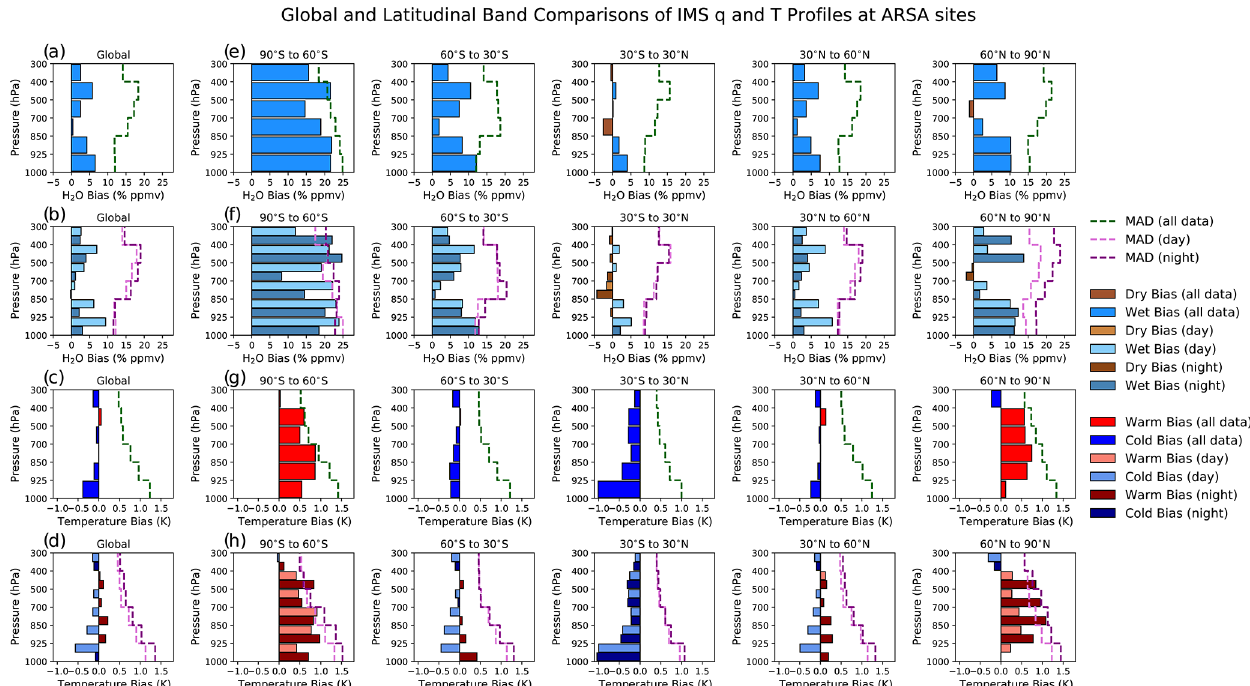
Figure 10. IMS profile biases relative to ARSA radiosonde measurements. Profile biases are shown for all global water vapour (a) and temperature (c) results, as well as the split between day and night biases ( b and d , respectively) in the same manner as Figs. 6 and 7. Biases for five broad latitude bands are also shown for water vapour and temperature comparisons (e, g) . Day and night biases for each latitude band are also given in (f) and (g) for water vapour and temperature profiles, respectively. Median absolute deviations (MADs) are shown as dashed lines for all matches and the day and night